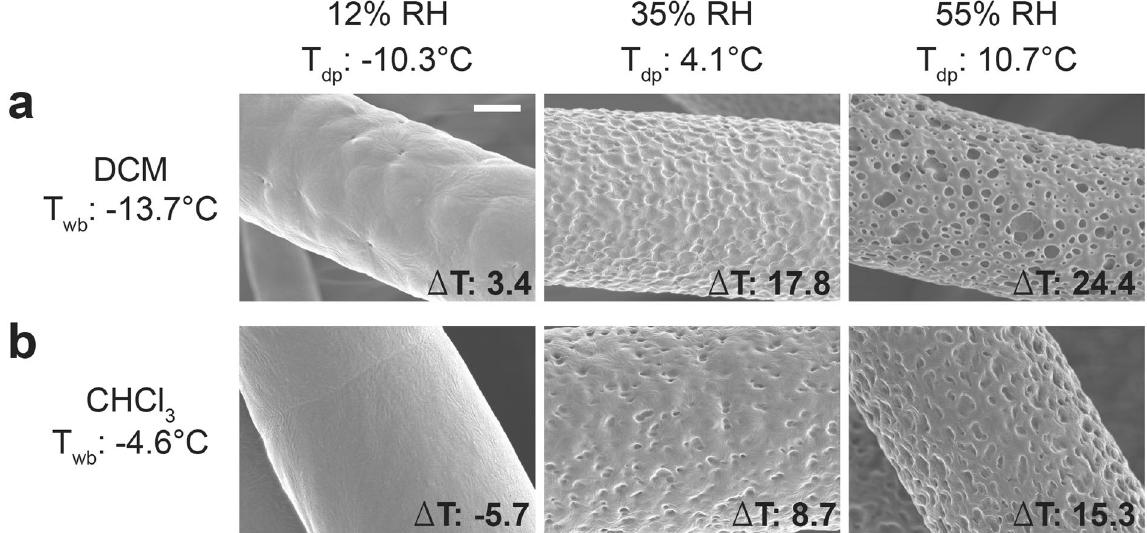
Figure 2. Morphologies of electrospun PCL fibers spun with DCM and CHCl 3 : SEM micrographs and corresponding Δ T ( T dp − T wb ) of ( a ) DCM (upper row) and ( b ) CHCl 3 (lower row) solution spun PCL fibers at 12%, 35% and 55% RH, respectively (scale bar: 2 µ